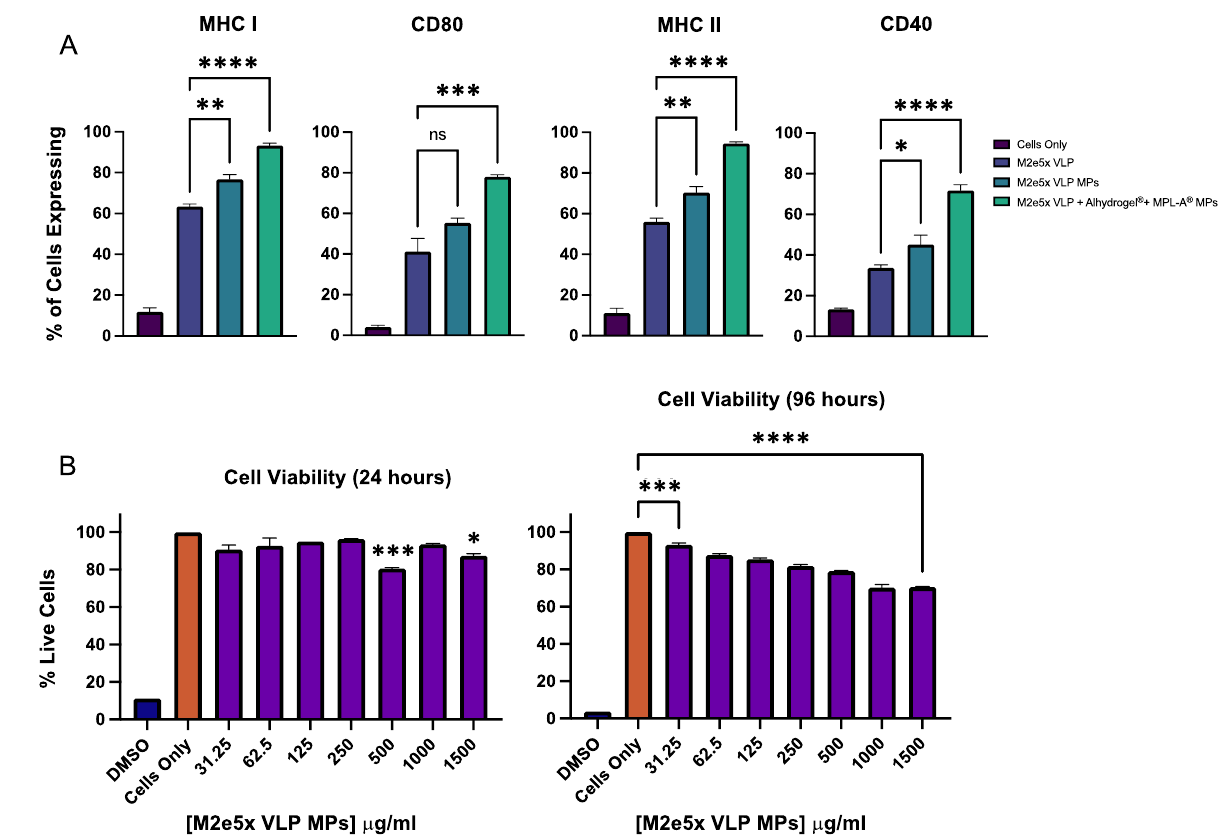
Figure 2. In vitro antigen presentation and cytotoxicity of MP vaccine. A) There is a significantly higher expression of MHC I in M2e5x VLP MPs (**p < 0.01) and M2e5x VLP + Alhydrogel ® + MPL-A ® MPs (****p < 0.0001) compared